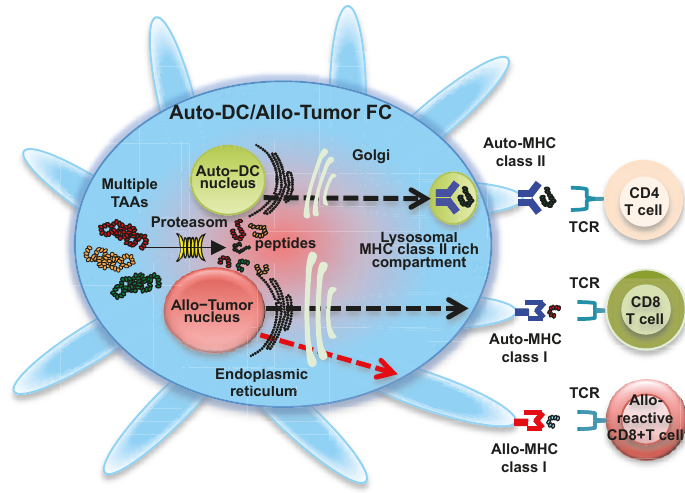
Figure 2. Fusion cells generated with autologous dendritic cells and allogeneic tumor cells. Fusions of autologous dendritic cells (Auto-DCs) and allogeneic tumor cells (Auto-DC/Allo-Tumor FC) display a characteristic phenotype comprised of major histocompatibility complex (MHC) class I molecules from autologous DCs and allogeneic tumor cells, MHC class II molecules from autologous DCs, co-stimulatory molecules (CD80 and CD86), and multiple tumor-associated antigens. Multiple tumor-associated antigens from allogeneic tumor cells are degraded by proteasome in Auto-DC/Allo-Tumor FC (solid line arrow), and antigenic peptides are loaded onto MHC class I molecules from autologous DC (black-colored dash line arrow) and allogeneic tumor cell (red-colored dash line arrow) in the endoplasmic reticulum. The peptide-MHC class I complexes are then expressed on the Auto-DC/Allo-Tumor FC surface and stimulate polyclonal antigen-specific CD8 + T cells and alloreactive CD8 + T cells. Auto-DC/Allo-Tumor FC can also synthesize MHC class II-restricted antigenic peptides in the endoplasmic reticulum. These are transported to the cytoplasm, where peptide-autologous MHC class II complexes are generated (black-colored dash line arrow). Peptide-autologous MHC class II complexes are also expressed on the Auto-DC/Allo-Tumor FC surface and activate polyclonal antigen-specific CD4 + T cells. Moreover, antigens derived from Auto-DC/Allo-Tumor FC are also be cross-presented by host DCs, resulting in the induction of polyclonal antigen-specific CD4 + and CD8 + T